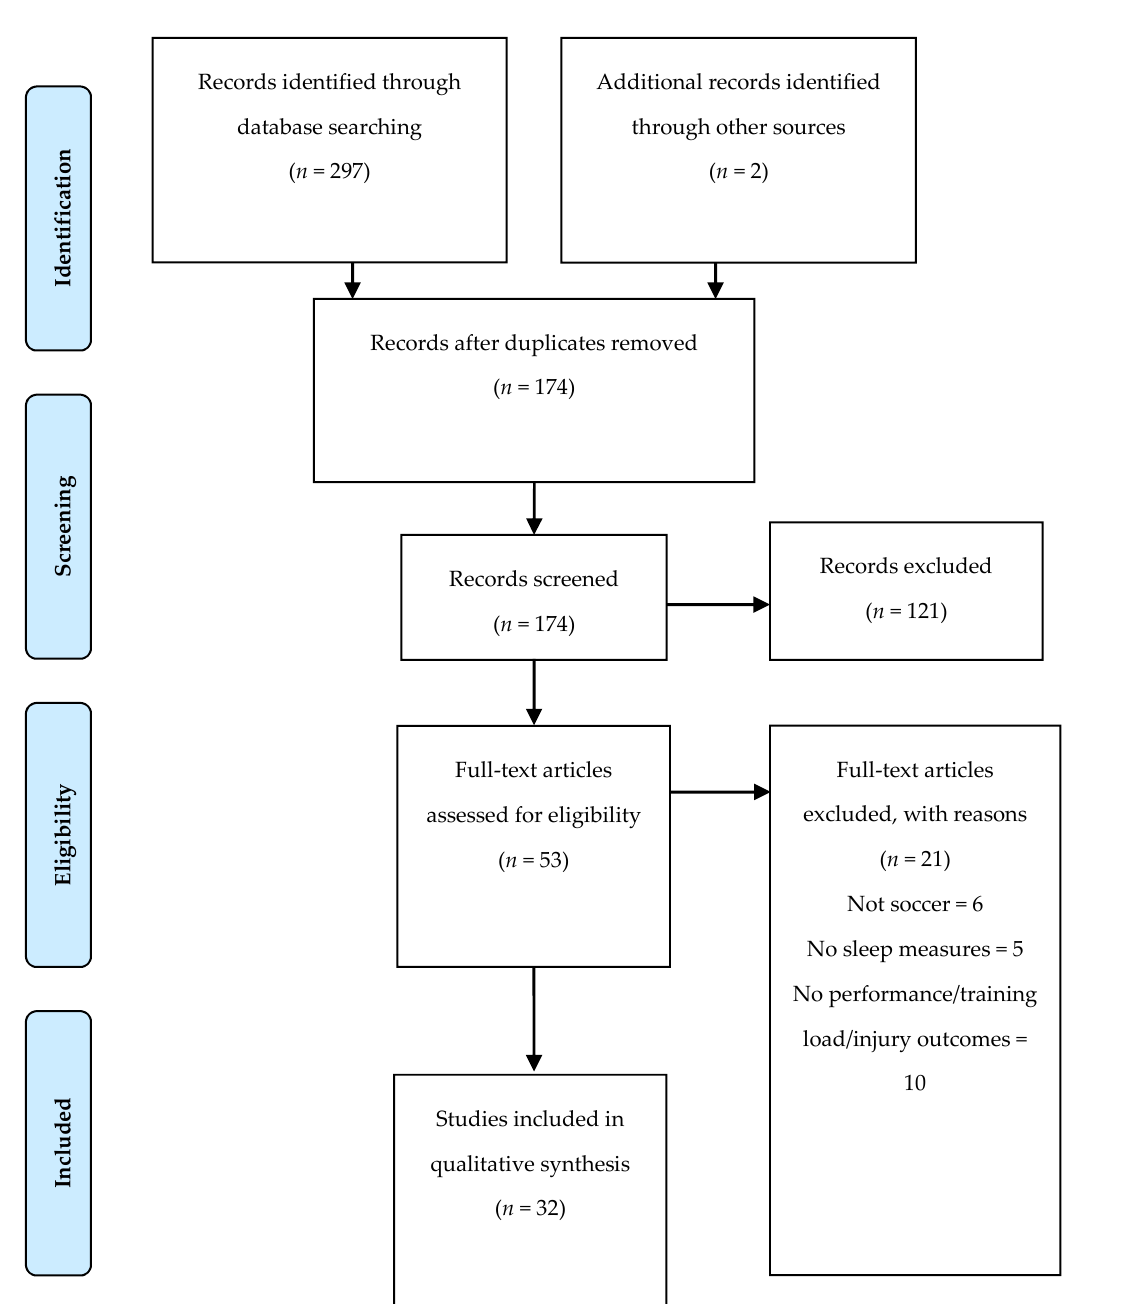
Figure 1. PRISMA flow diagram.